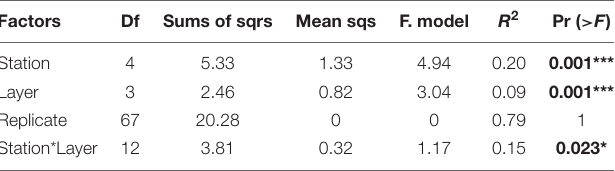
TABLE 4 | Permutational analysis of variance results for the metabarcoding dataset, considering the three factors “Station,” “Layer,” and “Replicate” and the interaction between significant values (Station*Layer).